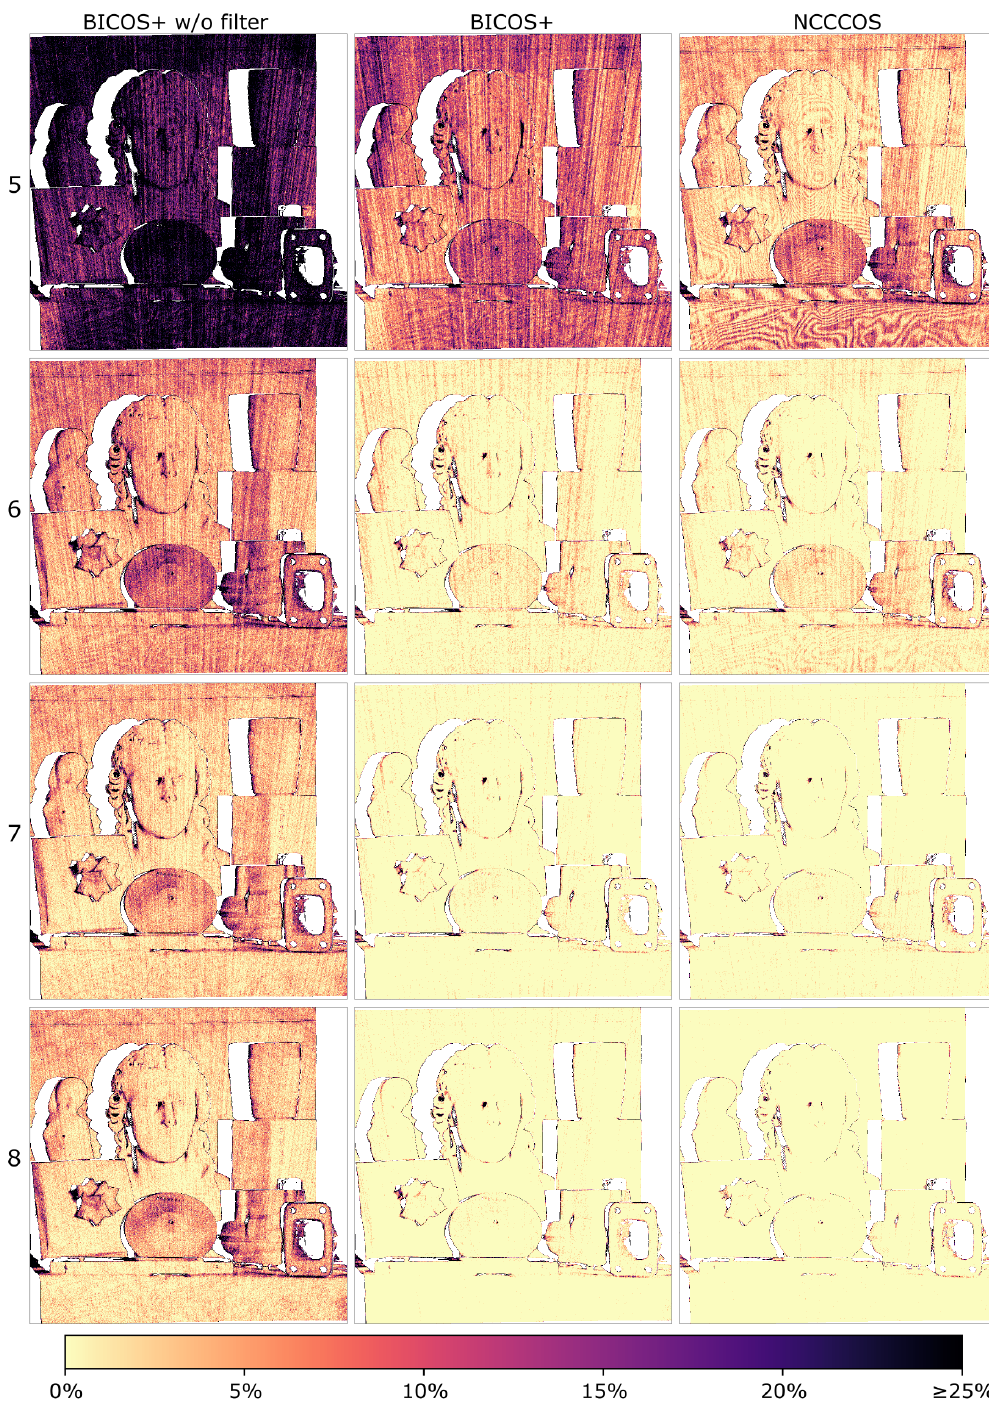
Figure 13. Percentage of wrong or missing correspondences (out of 39 data sets). Top to bottom: sequence lengths 5, 6, 7 and 8. Left to right: BICOS+ without median filter, BICOS+ (with median filter) and